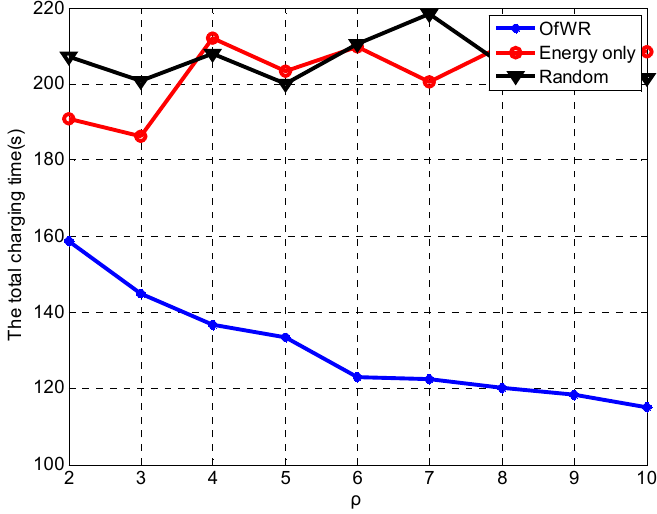
Figure 10. The comparison of the total charging time.